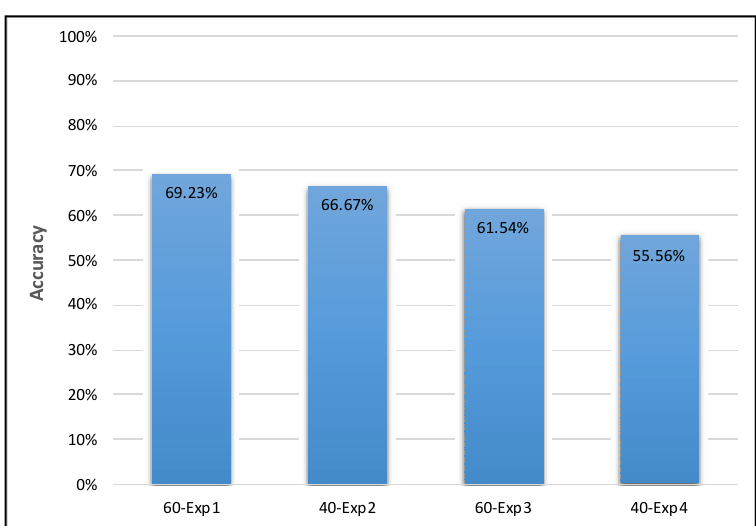
Figure 8. Comparison of the arousal experiments’ results. Table 3. Comparison of all experiments’ results.